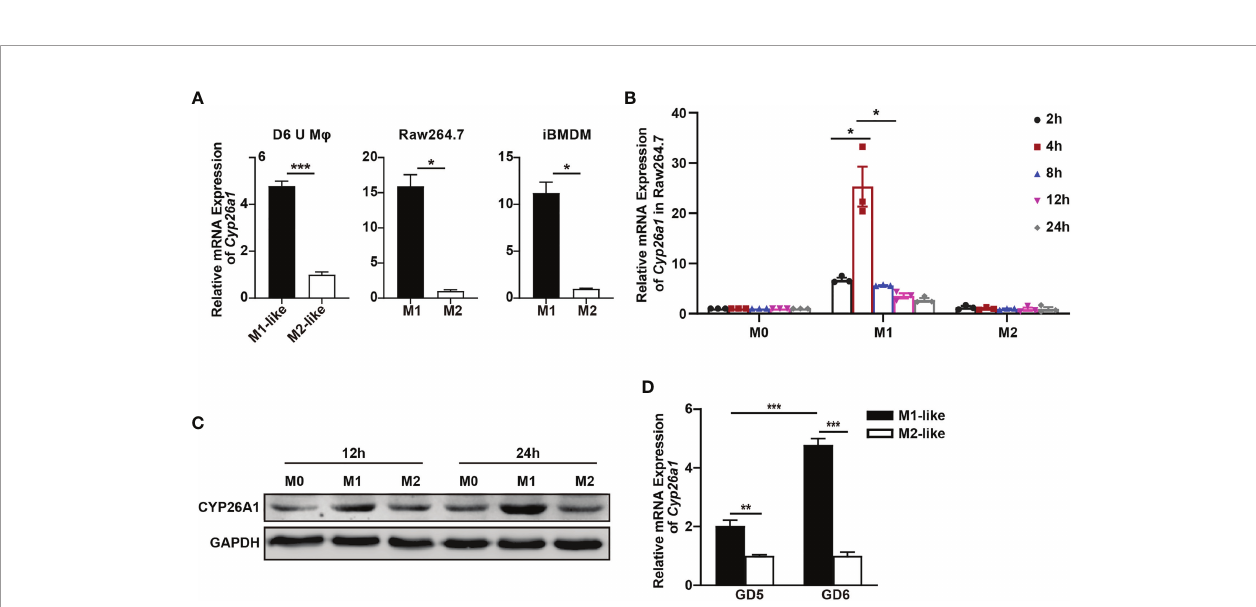
FIGURE 2 | Differential expression of Cyp26a1 in M1 and M2 macrophages. (A) qPCR analysis of Cyp26a1 in M1 and M2 of GD6 uterine macrophages (D6 U M j ), Raw264.7 and iBMDM (n=3). (B) qPCR analysis of Cyp26a1 in M0, M1 and M2 macrophages of Raw264.7 at different induction time (LPS (100 ng/mL) + IFN- g (20 ng/mL); 2 h, 4 h, 8 h, 12 h and 24 h; n=3). (C) Protein expression of CYP26A1 in M0, M1, M2 macrophages of Raw264.7 at different induction time (12 h and 24 h) was analyzed by Western blot. GAPDH was used as loading control. (D) qPCR analysis of Cyp26a1 in M1-like and M2-like uterine macrophages of GD5 and GD6 (n=3). Error bars represent means ± SEM; two-tailed unpaired t-test, ns, not signi fi cant, *P < 0.05, **P < 0.01, or ***P <